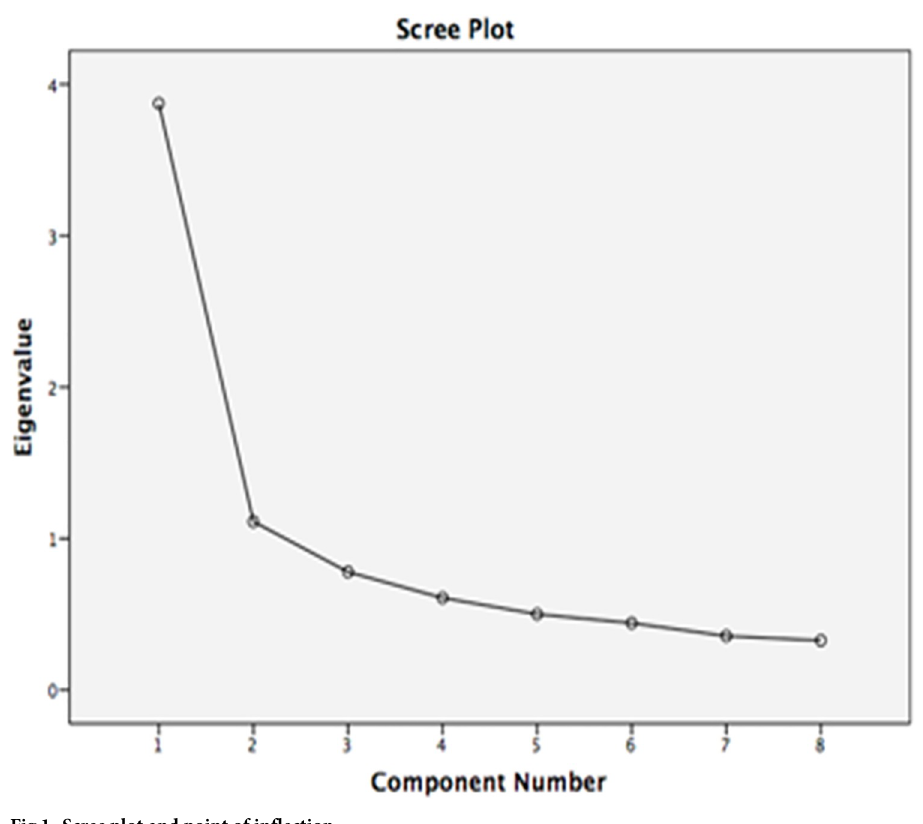
Fig 1. Scree plot and point of inflection.